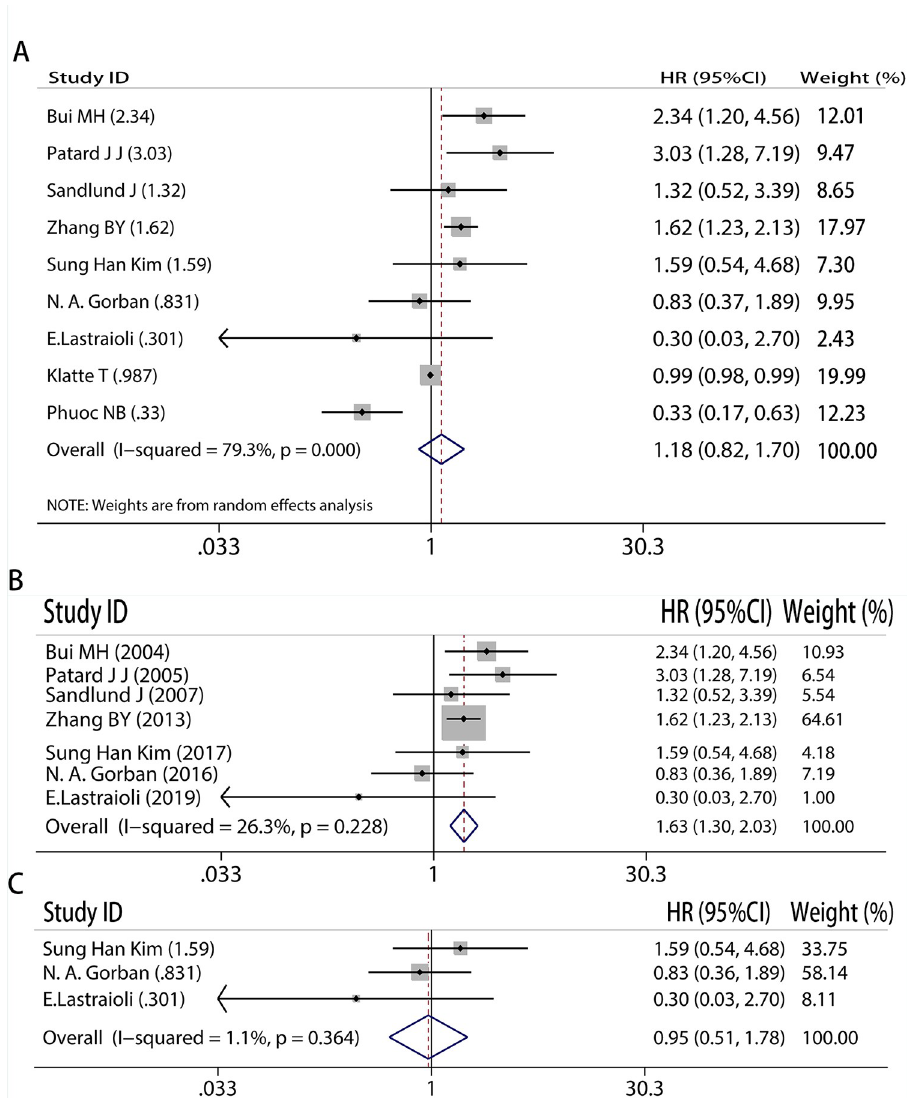
Fig 2. Meta-analysis of CAIX expression and disease-specific survival on A, all inclusion studies; B, by excluding the low quality score studies (quality score � 6); C, only including new studies.